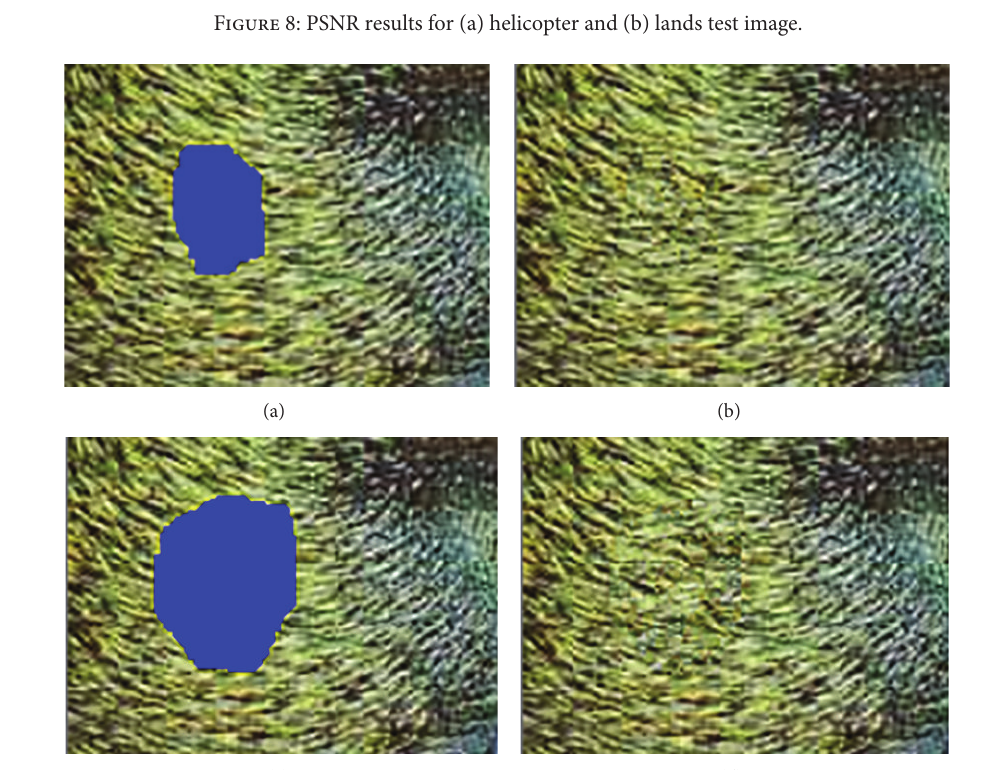
Figure 9: Test images with damage of (a) 983 pixels, (c) 2120 pixels and the corresponding results (b) and (d) obtained with Criminisi’s